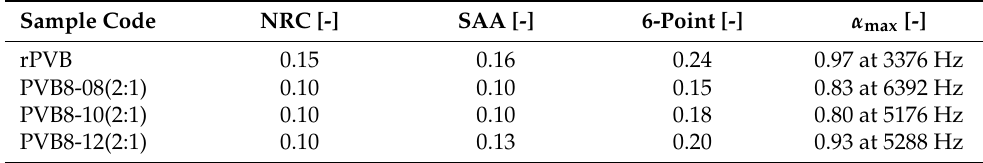
Table 9. The values of sound characteristics for chosen nanofibrous